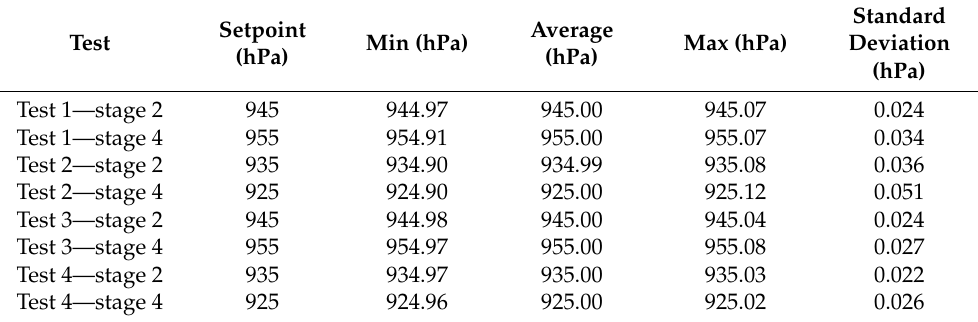
Table 1. Stability of barometric pressure (hPa) during the stages of steady setpoint (stages 2 and 4). The table shows descriptive statistics of the pressure setpoint for both short- and long-term